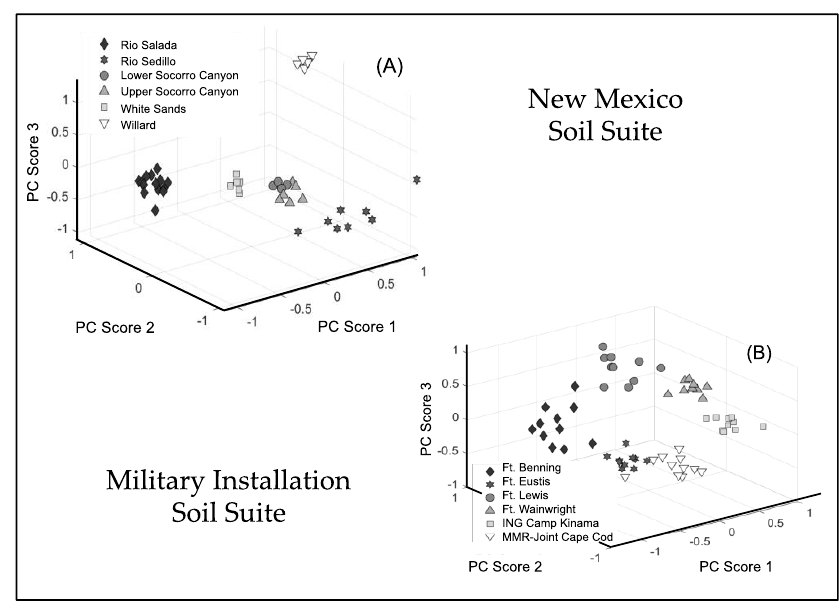
Figure 3. Principal component score plots of the fusion feature vectors for the New Mexico soil suite (A) and the military installation soil suite (B).